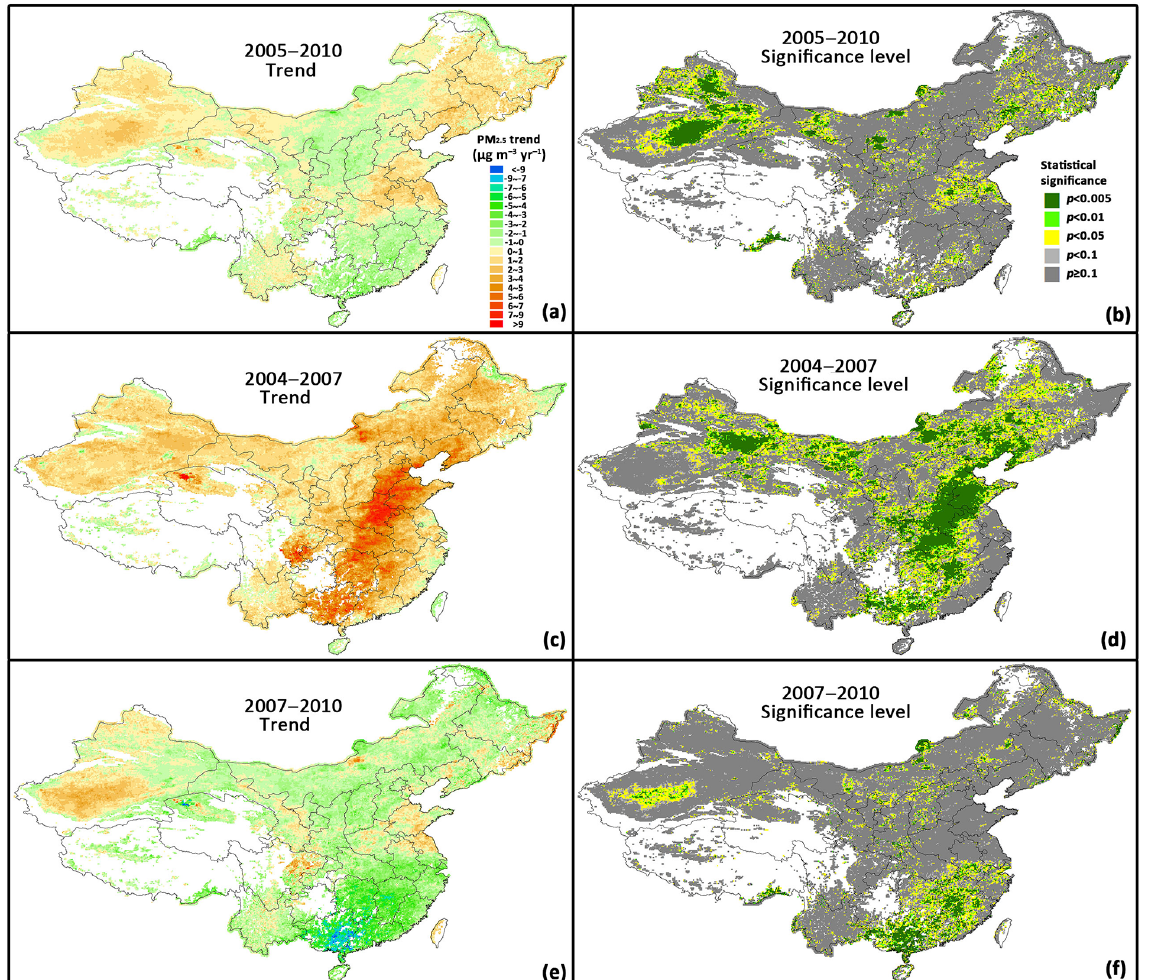
Figure 7. Spatial distributions of PM 2 . 5 trends and significance levels in China from 2005 to